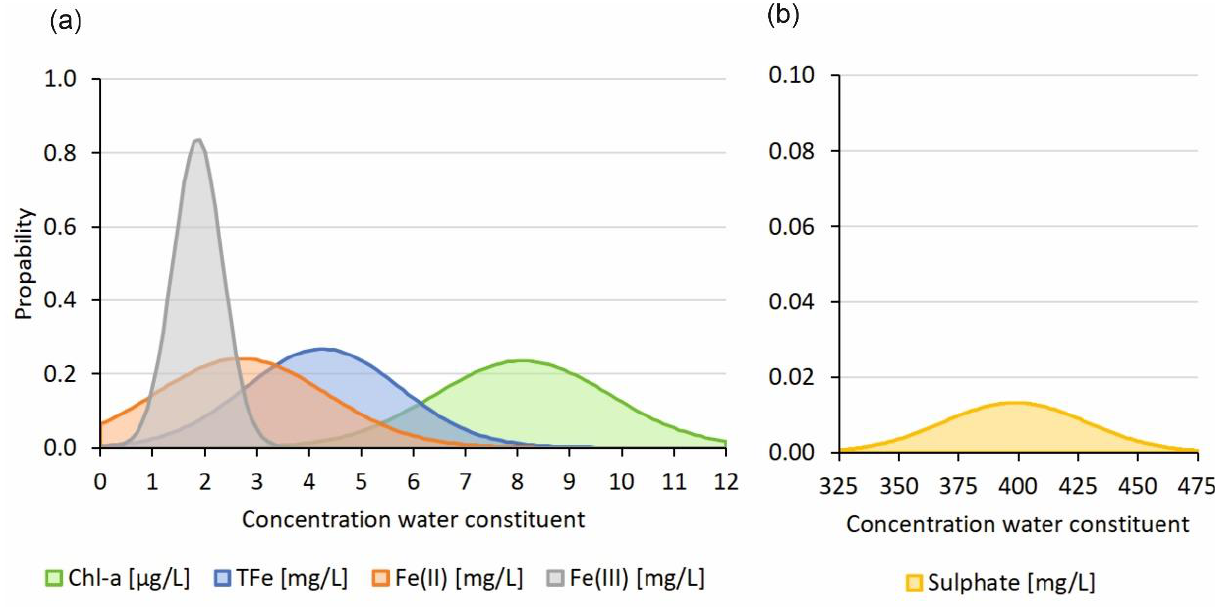
Figure 5. Plot of the distribution of the recorded in situ water parameter measurements: ( a ) Chl-a, TFe, Fe(II), Fe(III) and ( b ) sulphate based on a probability function in a concentration range from 0 to 475 mg/L. The value range of the sulphate concentration deviated strongly from the concentrations of the other water